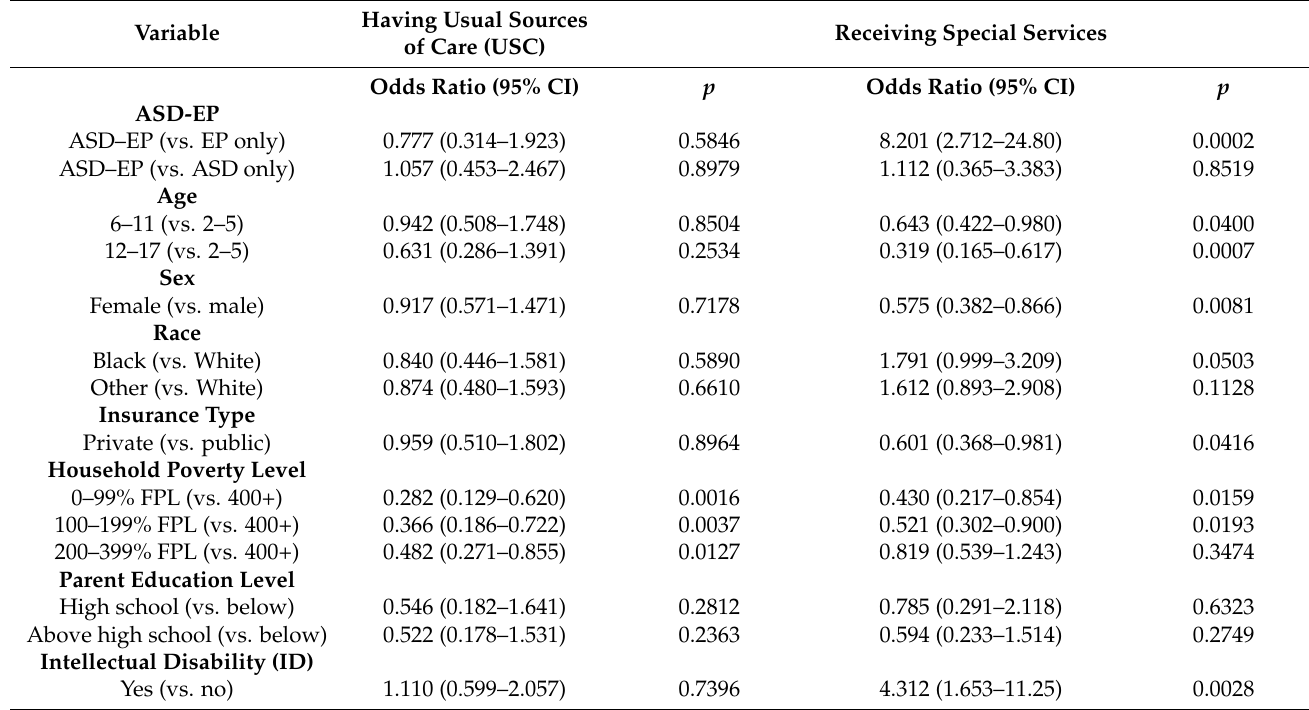
Table 6. Adjusted odds ratios for USC and special